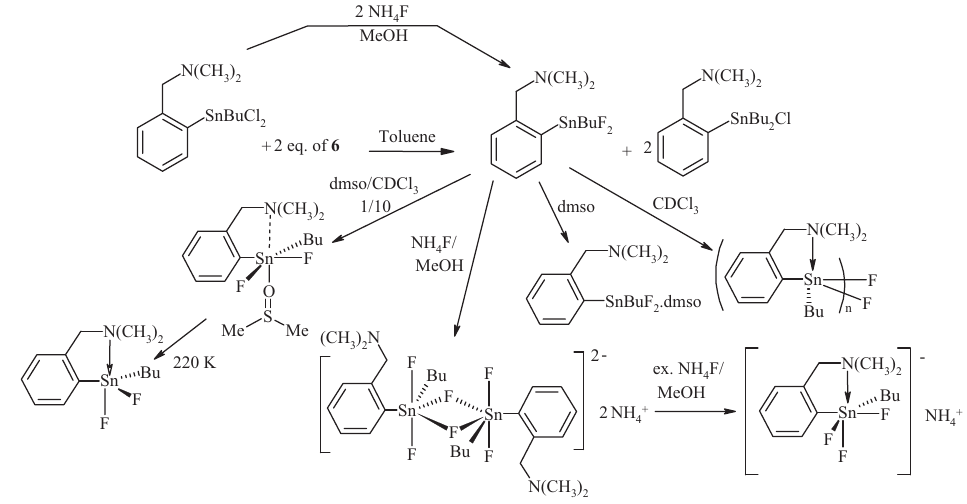
Figure 5 Fluorination of L CN ( n -Bu)SnCl